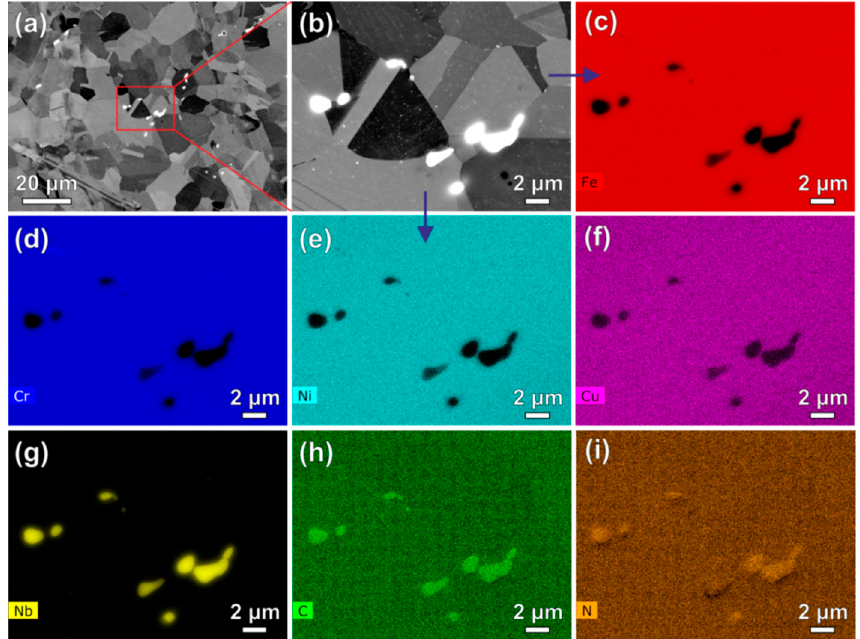
Figure 2. Back-scattered electron (BSE) images of the solution-treated Super304H steel sample with relatively low ( a ) and high ( b ) magnifications. ( c – i ) are the energy-dispersive X-ray spectroscopy (EDS) maps of elements Fe, Cr, Ni, Cu, Nb, C and N, respectively, corresponding to the identical sample region in ( b ).